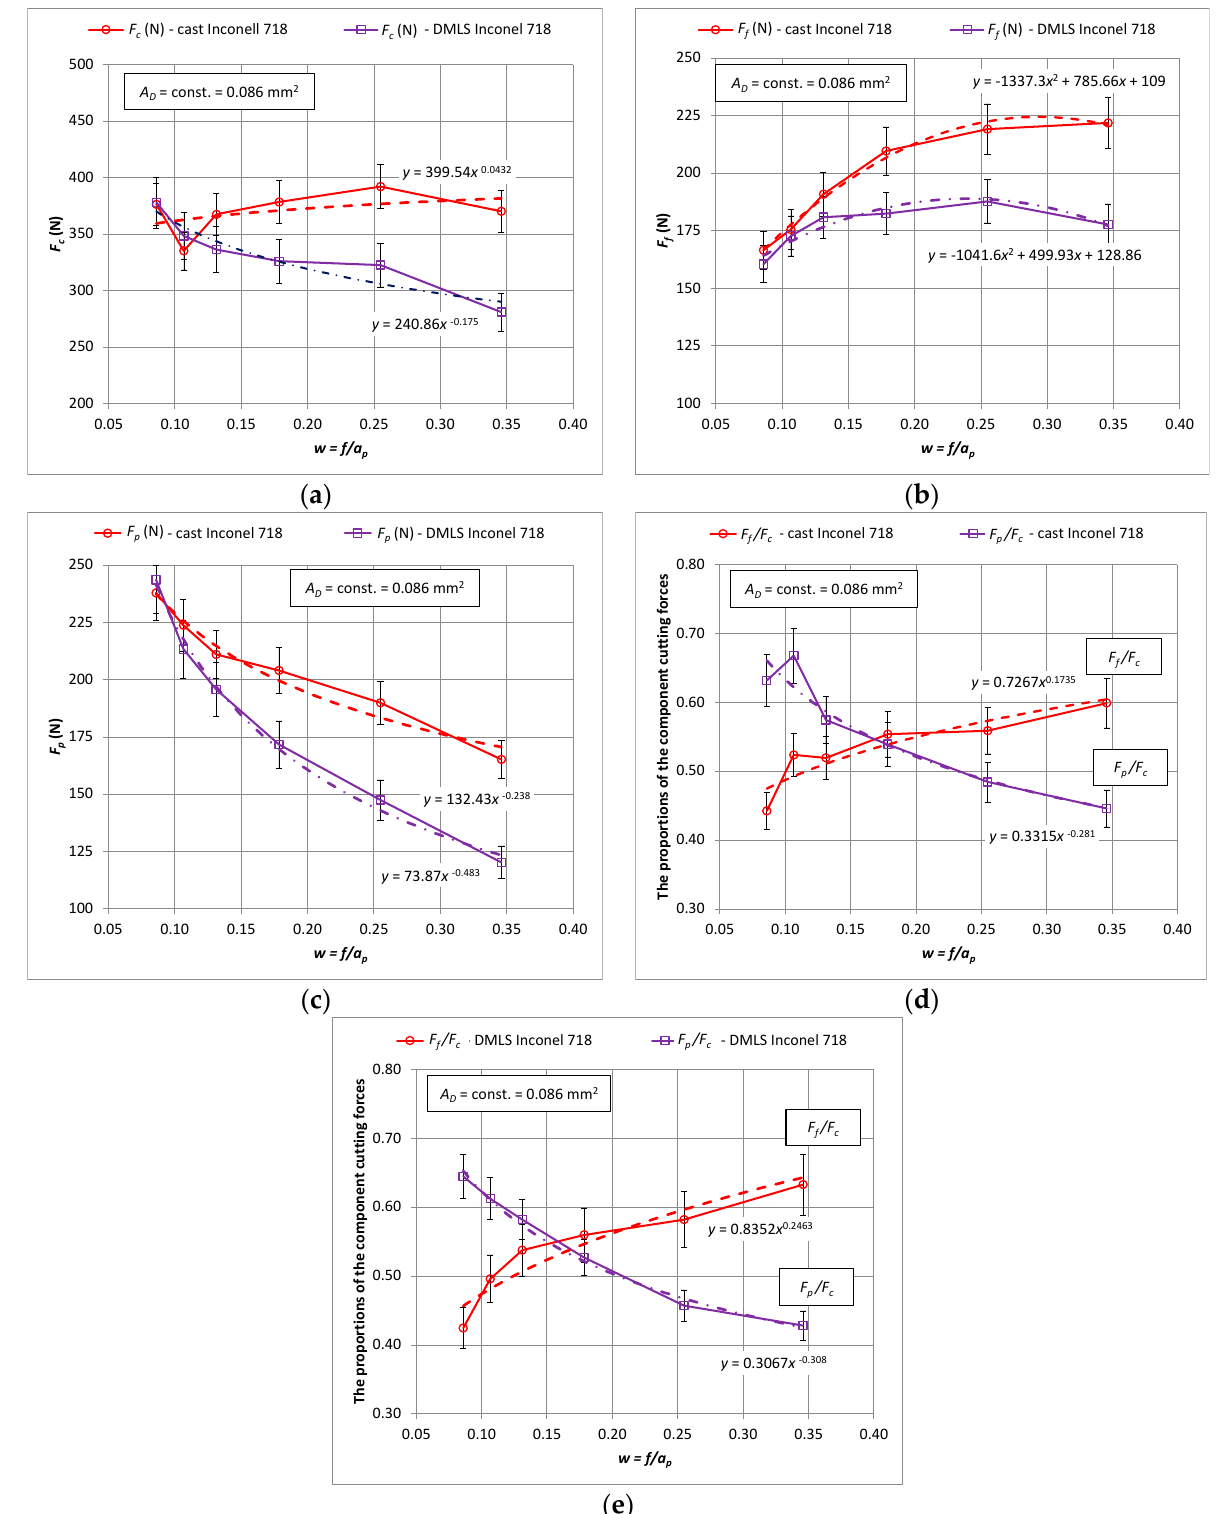
Figure 3. The characteristics of the components for turning with a constant cross-section of the machined layer A D = 0.8 mm 2 for the printed and cast Inconel 718 alloy, ( a ) F c component, ( b ) F f component, ( c ) F p component, ( d ) the ratio of the cutting forces F f / F c and F p / F c –cast material ( e ) the ratio of the cutting forces F f / F c and F p / F c –3D printed material.